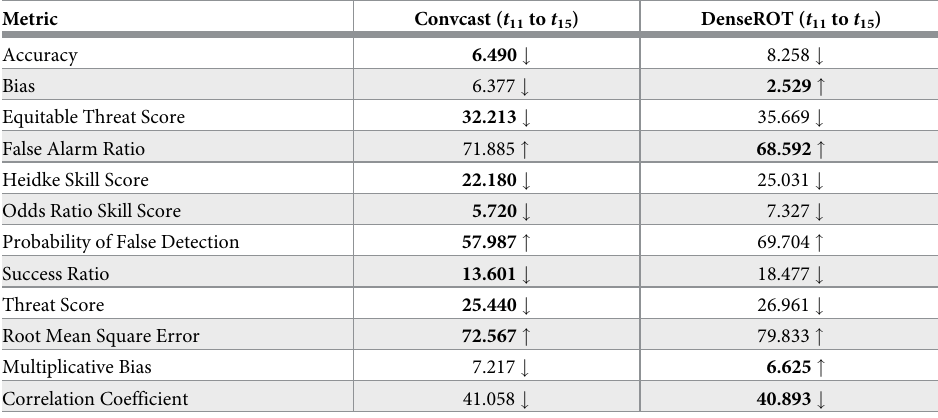
Table 7. Percentage increase " and decrease # in the forecast metric